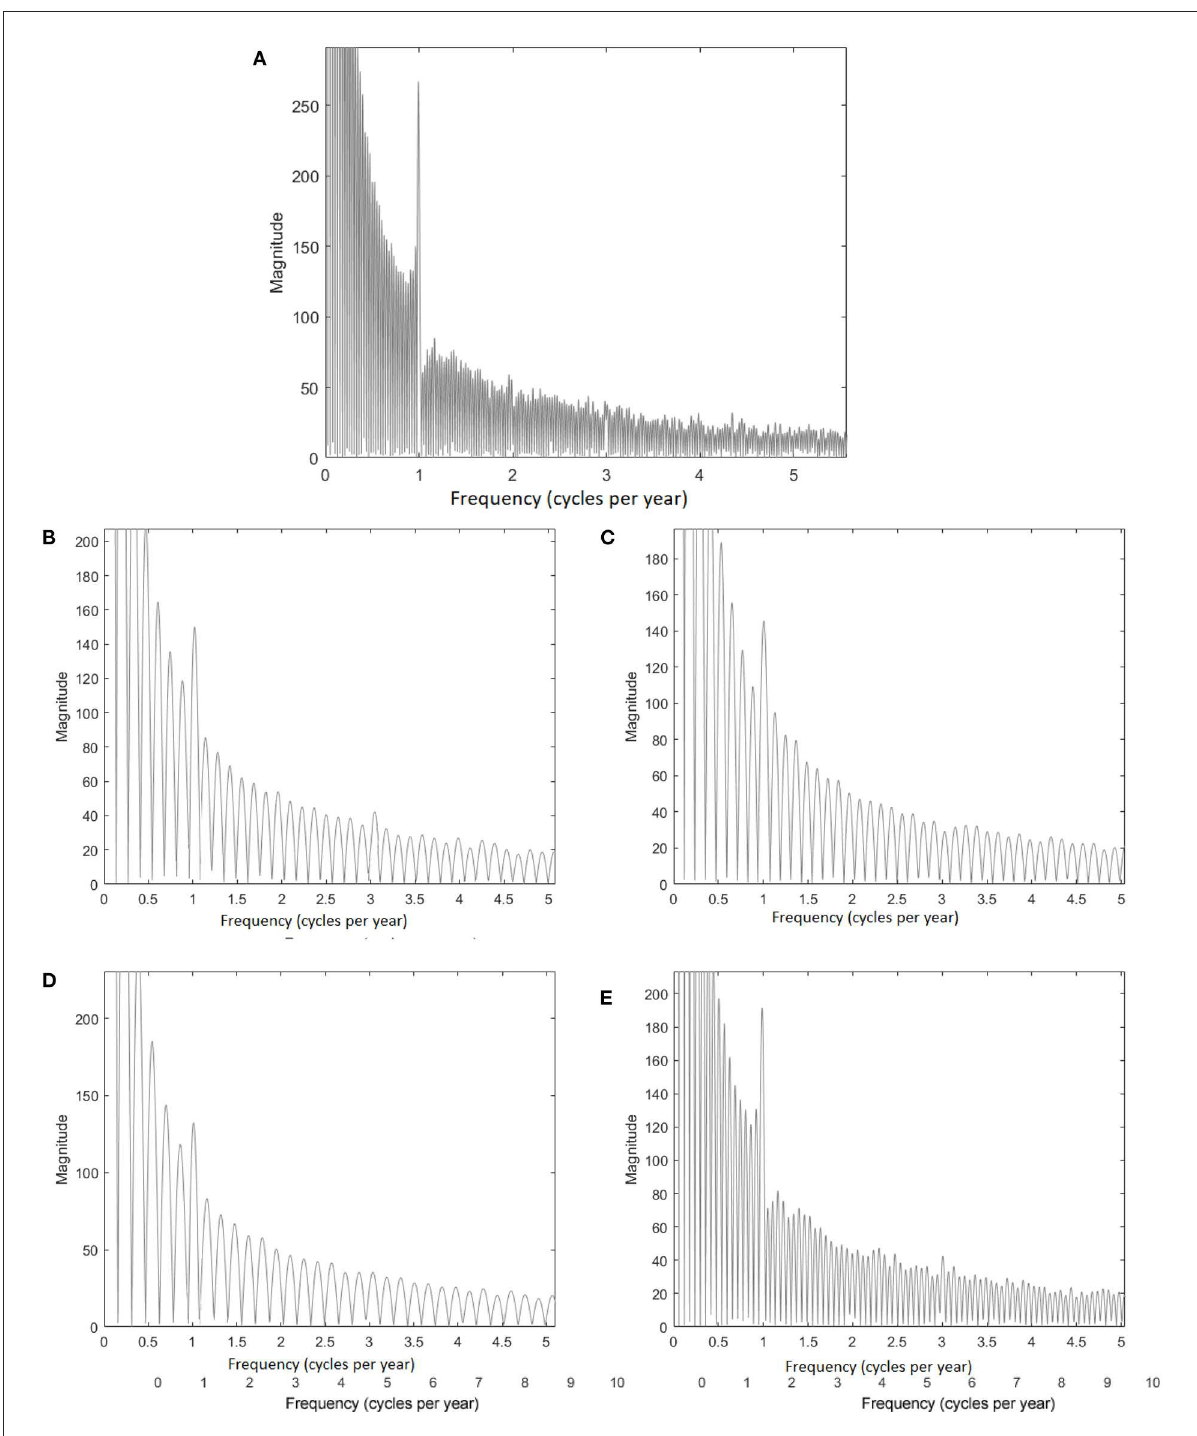
FIGURE3 As in Figure 2, but for R c over (A) 1979–2017, (B) 1979–1988, (C) 1988–1994, (D) 1994–2001, and (E) 2001–2017